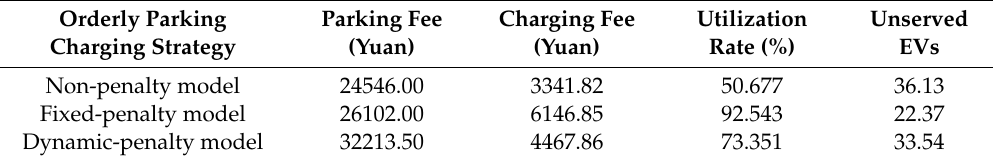
Figure 12. Comparison of unserved EVs.